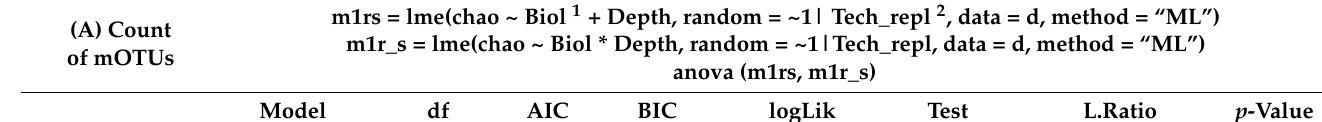
Table A2. LMM analysis and likelihood ratio test to determine the impact of depth to variation within biological replicates using ( A ) count of mOTUs and ( B ) raw